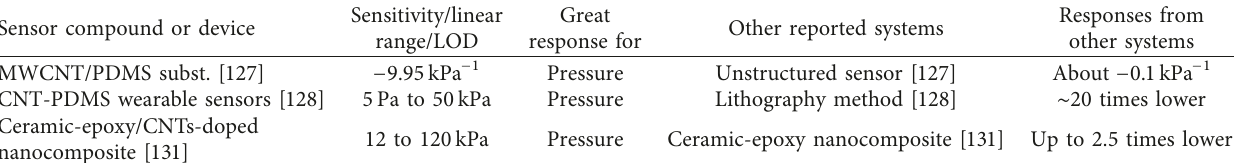
Table 5: Comparison between pressure sensor systems described in this review and those found in the literature. Sensor compound or